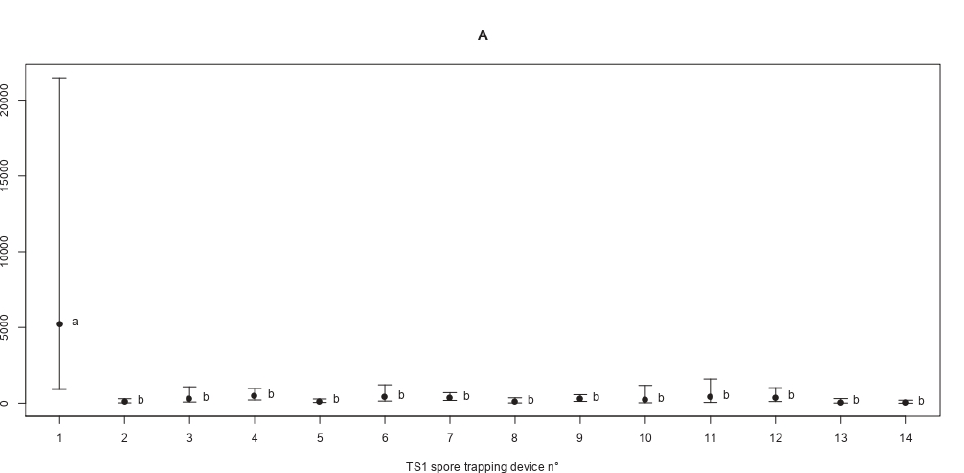
Figure 5. Patterns of the spatial propagule deposition of Cryphonectria parasitica . For sites TS1 (panel A ), TS2 (panel B ), and ES (panel C ), the mean deposition rate (DR) of the fungal pathogen and the 95% confidence interval are displayed for the different spore traps labelled from 1 to 14 as dots and t-shaped lines, respectively. Different letters are used to highlight significant differences ( p < 0.05) among average DRs depending on the spore trap locations along the linear transect.